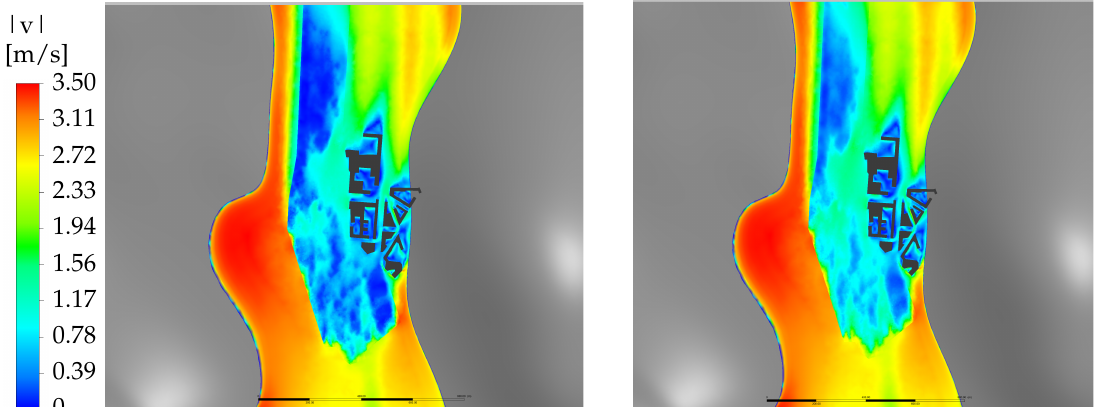
Figure 7. Velocity field with volume force modelled vegetation in summer ( left ) and in winter ( right